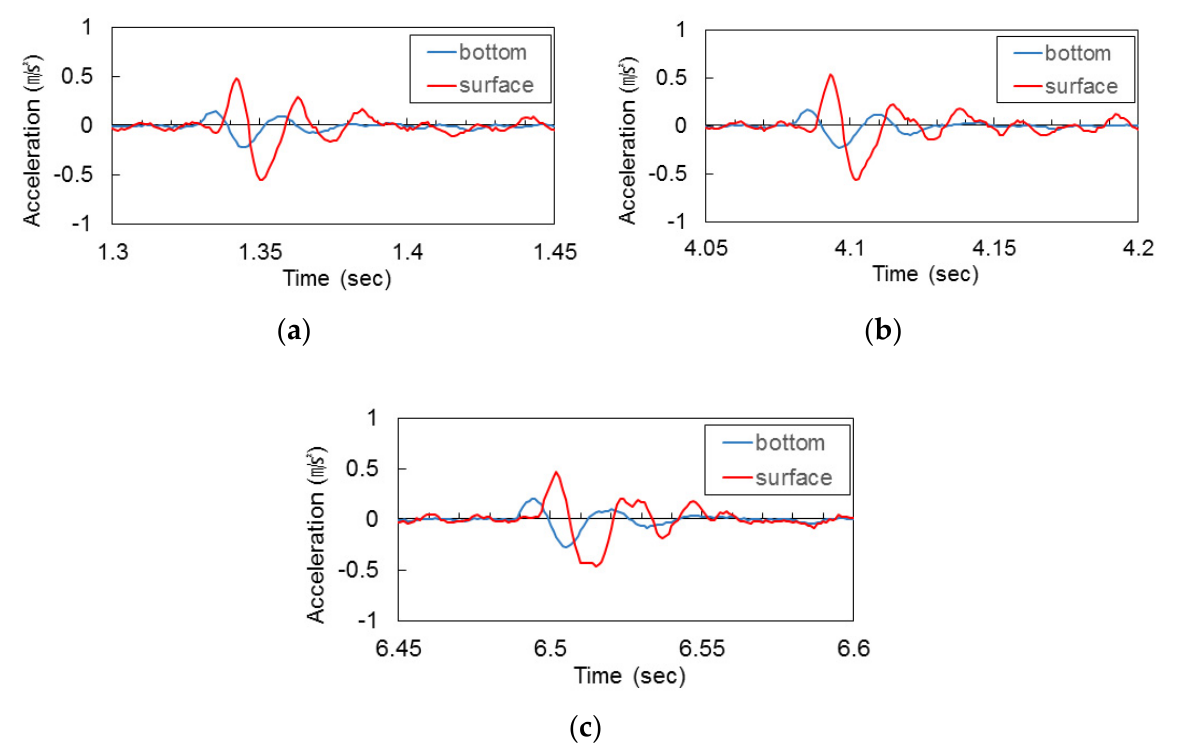
Figure 7. Hammer test result: ( a ) Hammer test 1st; ( b ) Hammer test 2nd; ( c ) Hammer test 3rd.